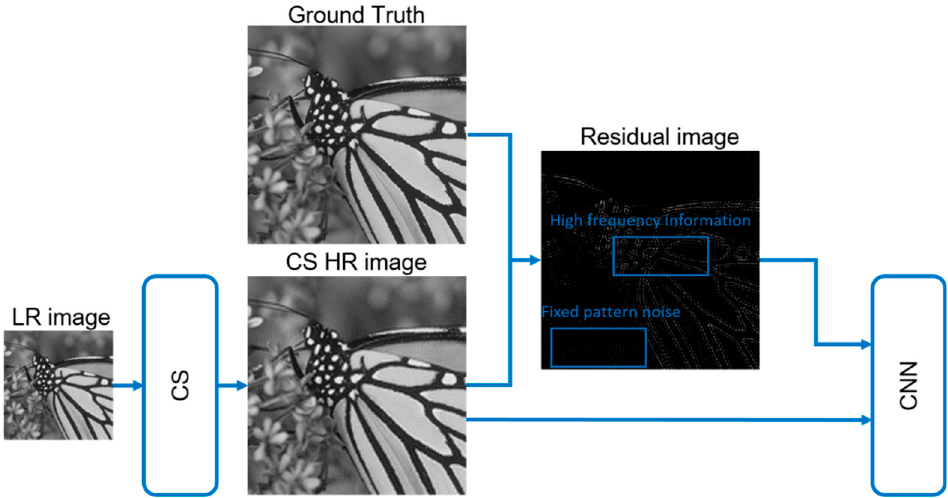
Figure 2. The residual learning progress of our method.